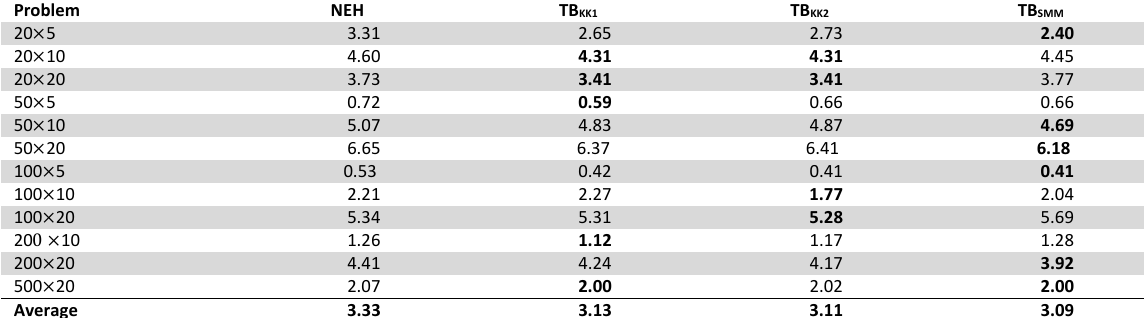
ARPD values of different tie breaking rules on Taillard instances Problem